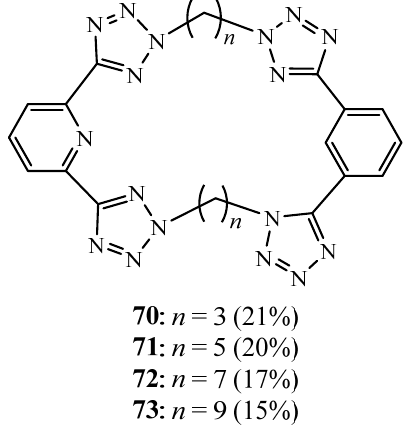
Figure 19. Tetrazolic macrocycle bearing pyridine moiety 70 − 73. (Reprinted with permission from ref. [34]. Copyright 2011 Elsevier).